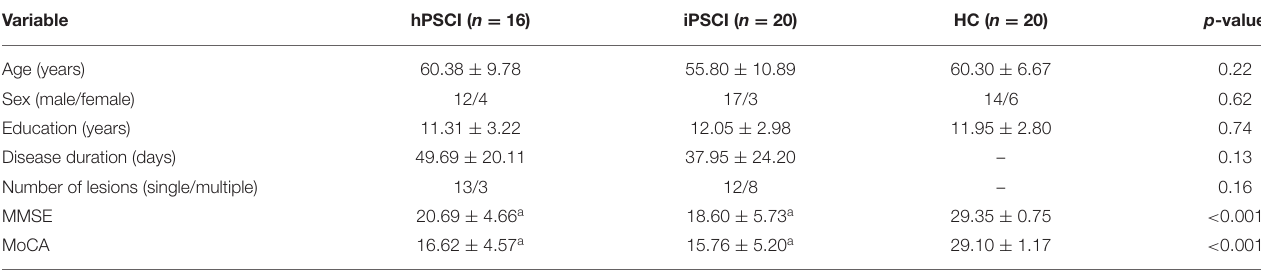
TABLE 1 | Demographic, clinical, and neuropsychological data in cognitive impairment group after hemorrhagic stroke (hPSCI group), the cognitive impairment group after ischemic stroke (iPSCI group) and healthy control group (HC group).